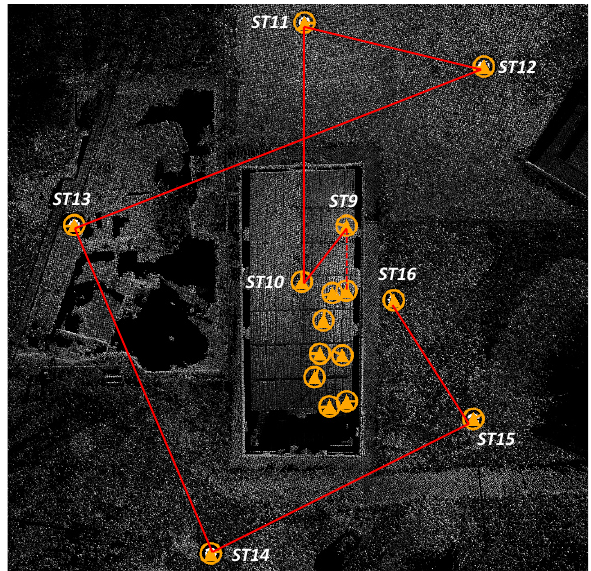
Figure 9. The scheme of scan points inside and outside the Saint John